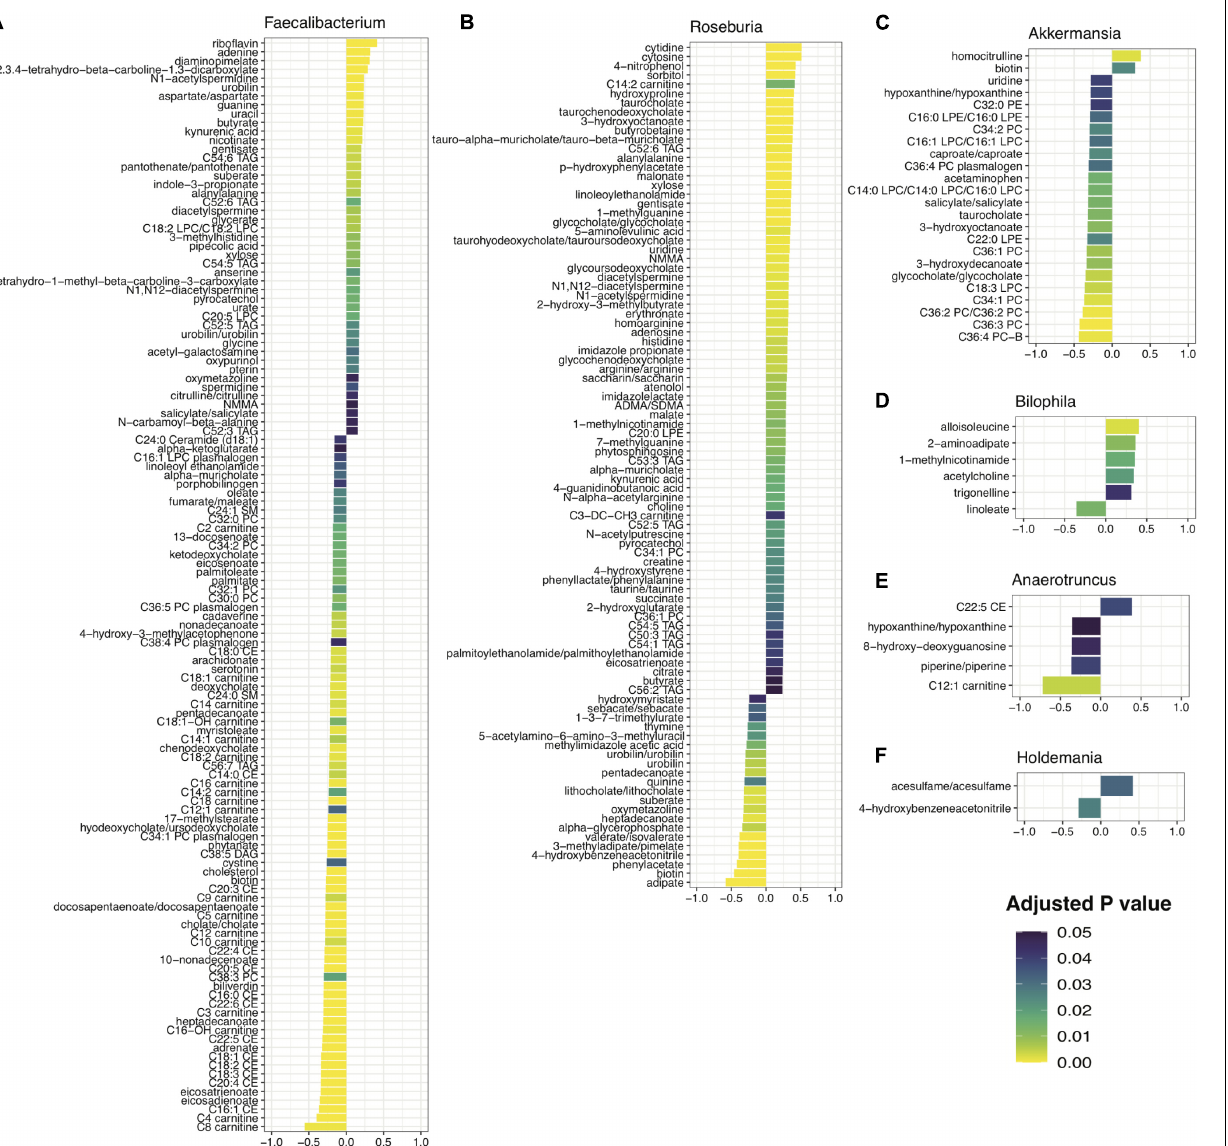
FIGURE 6 | Metabolites significantly correlated with disease-predictive taxa: (A) Faecalibacterium, (B) Roseburia, (C) Akkermansia, (D) Bilophila, (E) Anaerotruncus, and (F) Holdemania. Spearman correlation coefficient scores plotted and shaded by adjusted p -value for 6 taxa found to be predictive of IBD, MS, and RA based on the multiple disease model